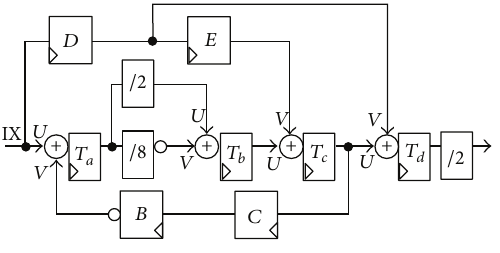
Figure 4: Half band filter data